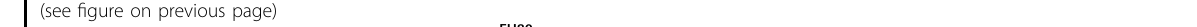
(Fig. 1g, h). After receiving lymphodepleting chemother- apy with fl udarabine (30 mg/m 2 /day) and cyclopho- sphamide (250 mg/m 2 /day), all patients received 1 (range, 0.68 to 9.4) × 10 6 CD22-CAR FH80 T cells per kilogram